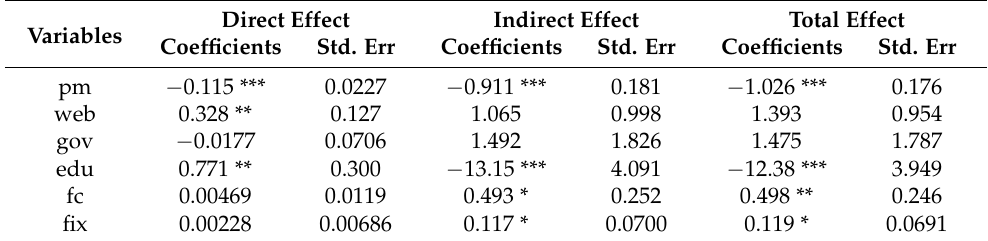
Table 5. Direct, indirect and total effects for Table 4.